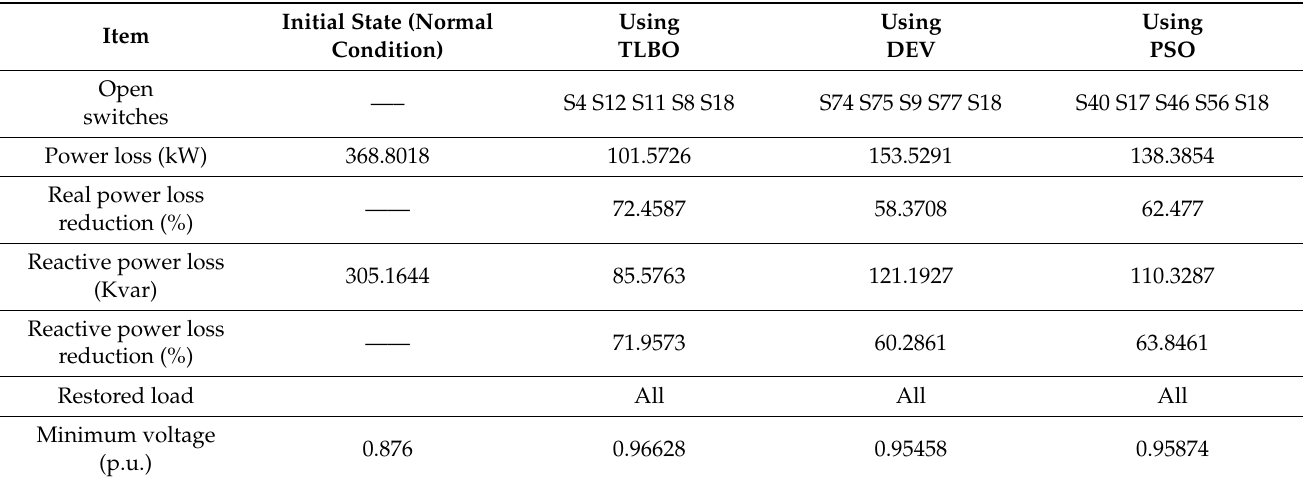
Table 1. SR simulation result for single fault case without considering protection constraints.